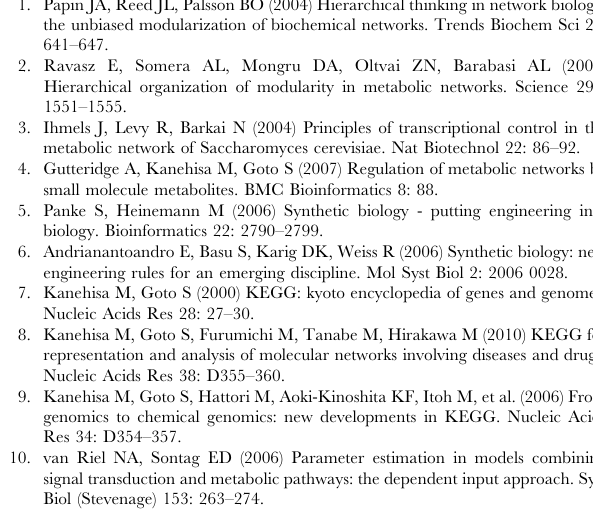
Figure S1 Network of terminal modules from the partitioning of the EGFR signaling network using Newman’s connectivity (A) and ShReD (B). The interactions between modules represent interac- tions between reactions in the respective modules. The size of a